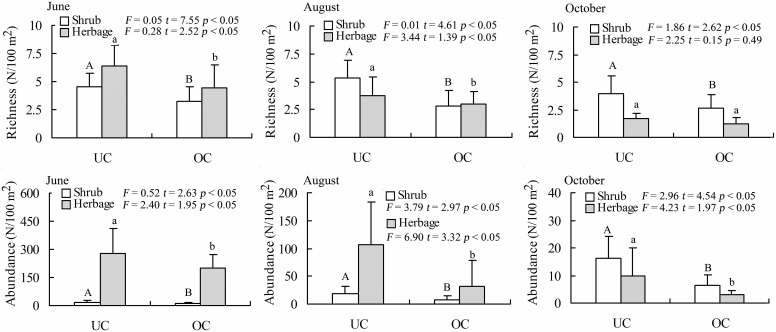
Difference in richness and abundance along plant growing season between UC and OC.UC is the community under the P. euphratica canopy, whereas the OC is the community outside the P. euphratica canopy. Blank and grid boxes indicate shrub and herbage, respectively. The Independent sample t-test is used to analyze the differences of richness and abundance between UC and OC. Different capital letters on each blank box indicate significant differences of shrub richness or abundance between UC and OC. Different lowercase letters on each grid box indicate significant differences of herbage richness or abundance between UC and OC. p<0.05. Numbers in figure are the results of Independent sample t-test. (Mean ± SD) for significance difference between UC and OC.